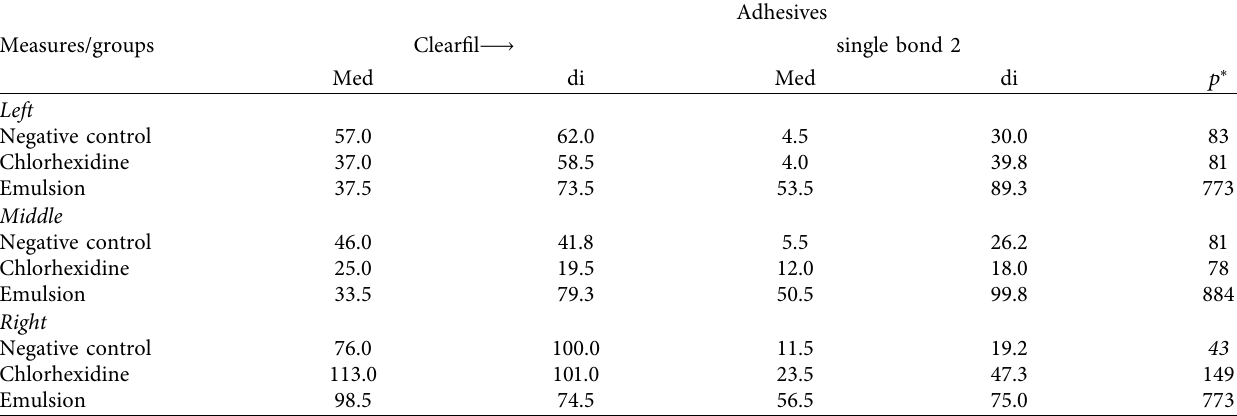
Table 4: Comparison in relation to adhesive systems according to measures and groups, Manaus, AM.